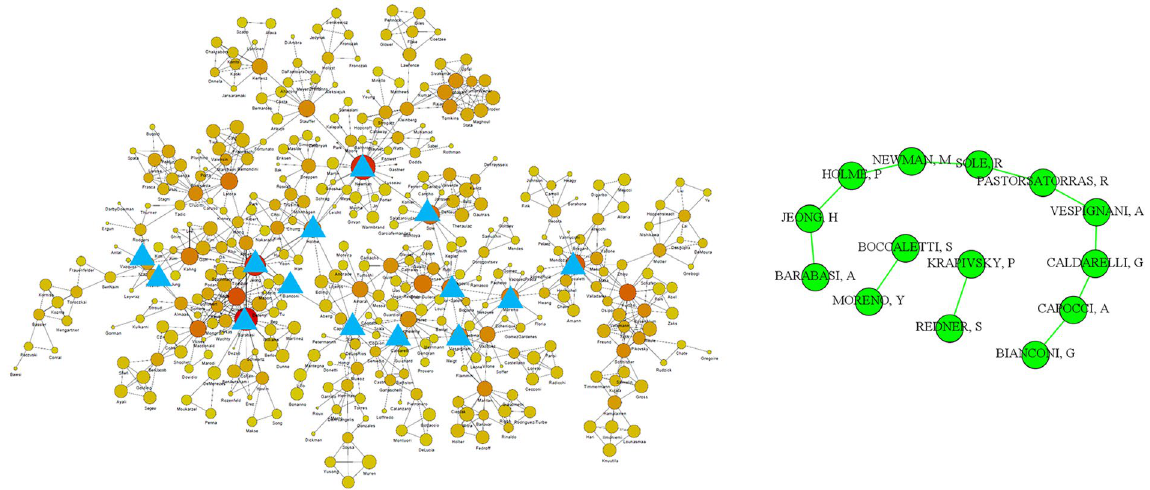
Figure 3. The h-backbone of the coauthorship in network science.